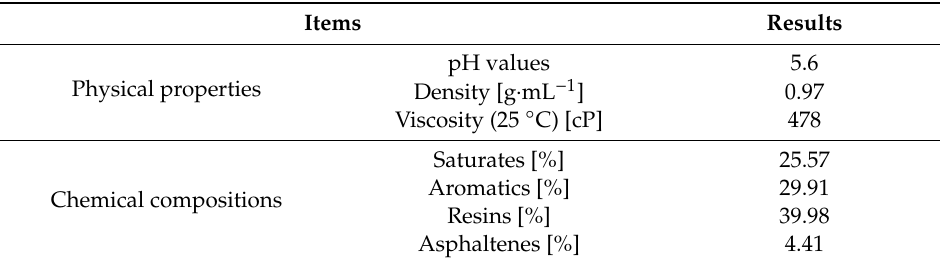
Table 4. Test samples and labels.